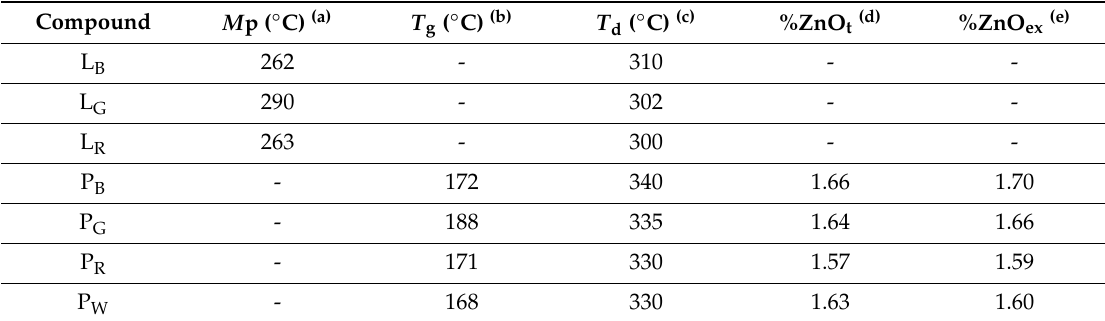
Table 1. Thermal data of ligands and polymers.